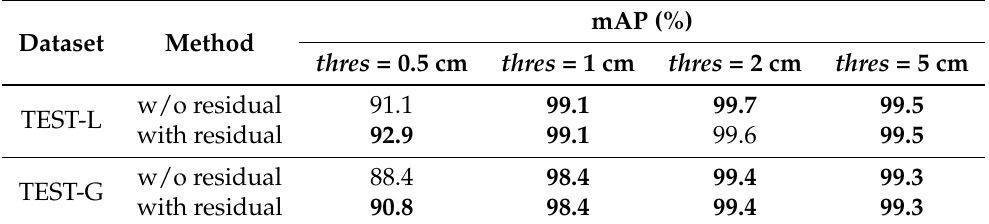
Table 4. Ablation study on translation prediction (w/o residual: regress the prediction without residual modules).